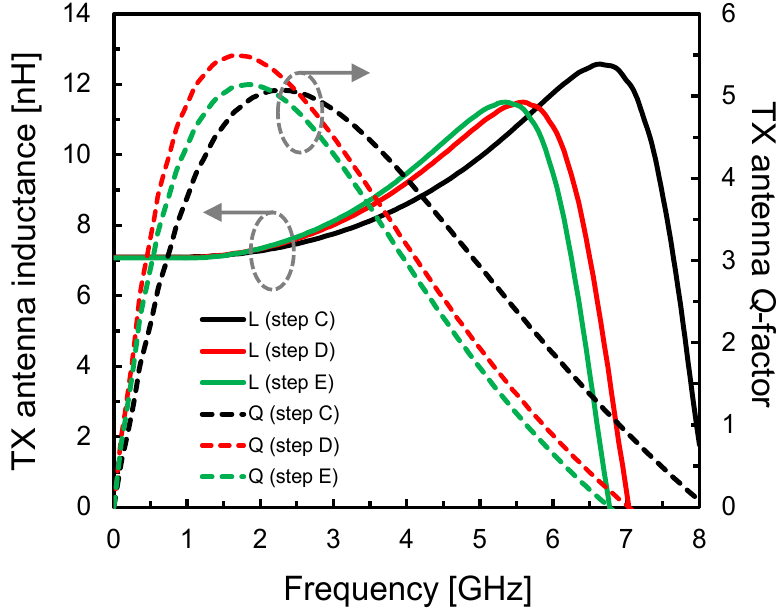
Figure 15. Inductance and Q-factor of the TX antenna for steps C, D, and E.